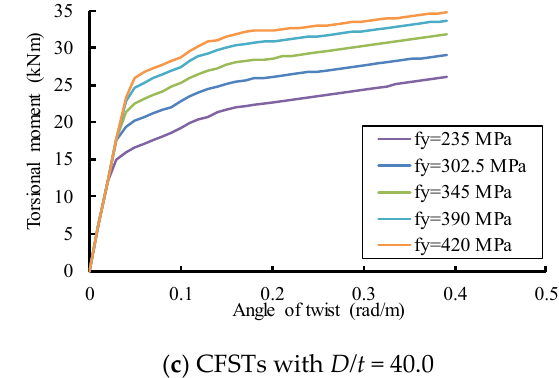
Figure 10. Effect of yield strength of steel on the torsional behavior of CFSTs with different D/t ratios.